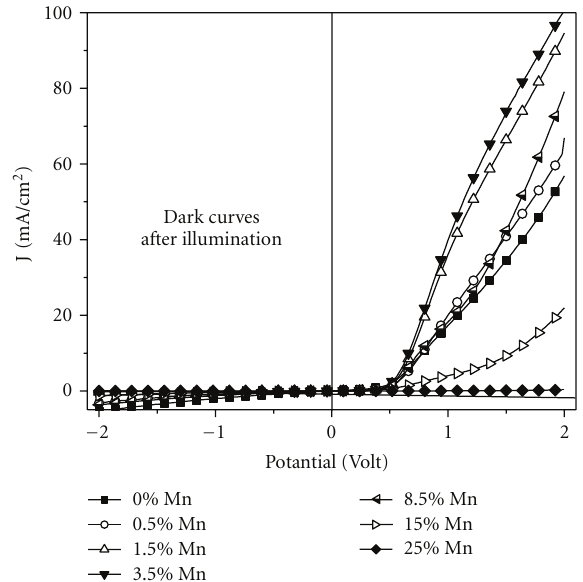
Figure 5: J-V characteristic curves for TiO 2 - and Mn-doped TiO 2 solarcells under dark circumstances (after 60-minute